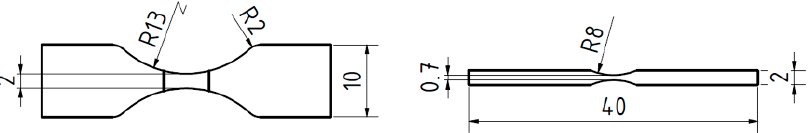
Figure 1. Sample geometry in mm.